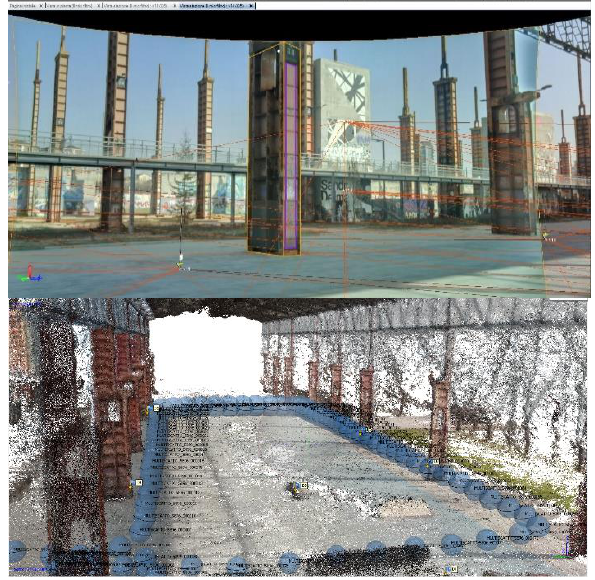
Figure 7. (top) Definition of vector polygons based on depth planes from V10 panoramas; (bottom) GoPro spherical